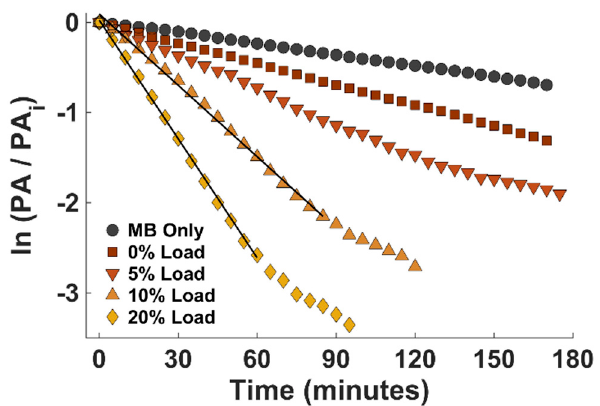
Figure 4. First-order kinetic plots (natural log of concentration relative to initial concentration) for MB solution using a series of beads with different TiO 2 loads. Also shown are inert PDMS beads (0% load) and photolysis of MB solution without any additives (MB Only). The slopes of the lines indicate the rate constant for loss of MB by adsorption, photolysis, and photocatalytic degradation. Two linear regions are observed for 20% and 10% loads due to MB adsorption equilibrium onto the beads resulting in a slight decrease in the removal rate; the value of k TOT is based on the first region, indicated with a line in the plot.